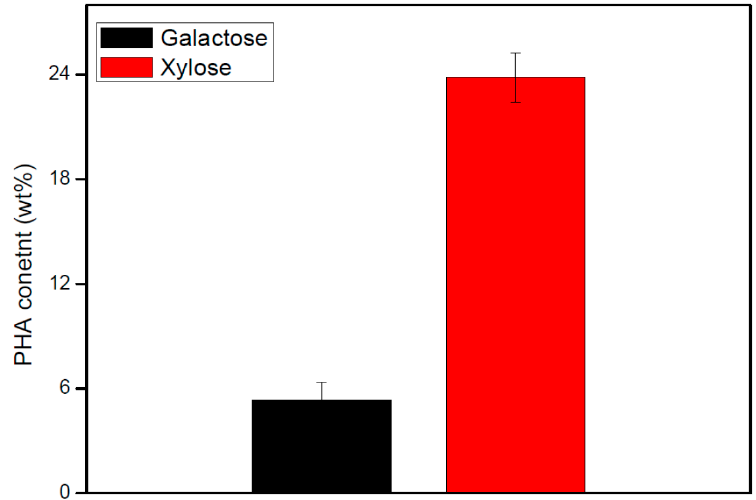
Figure 9. PHA production by B. cereus from galactose and xylose.